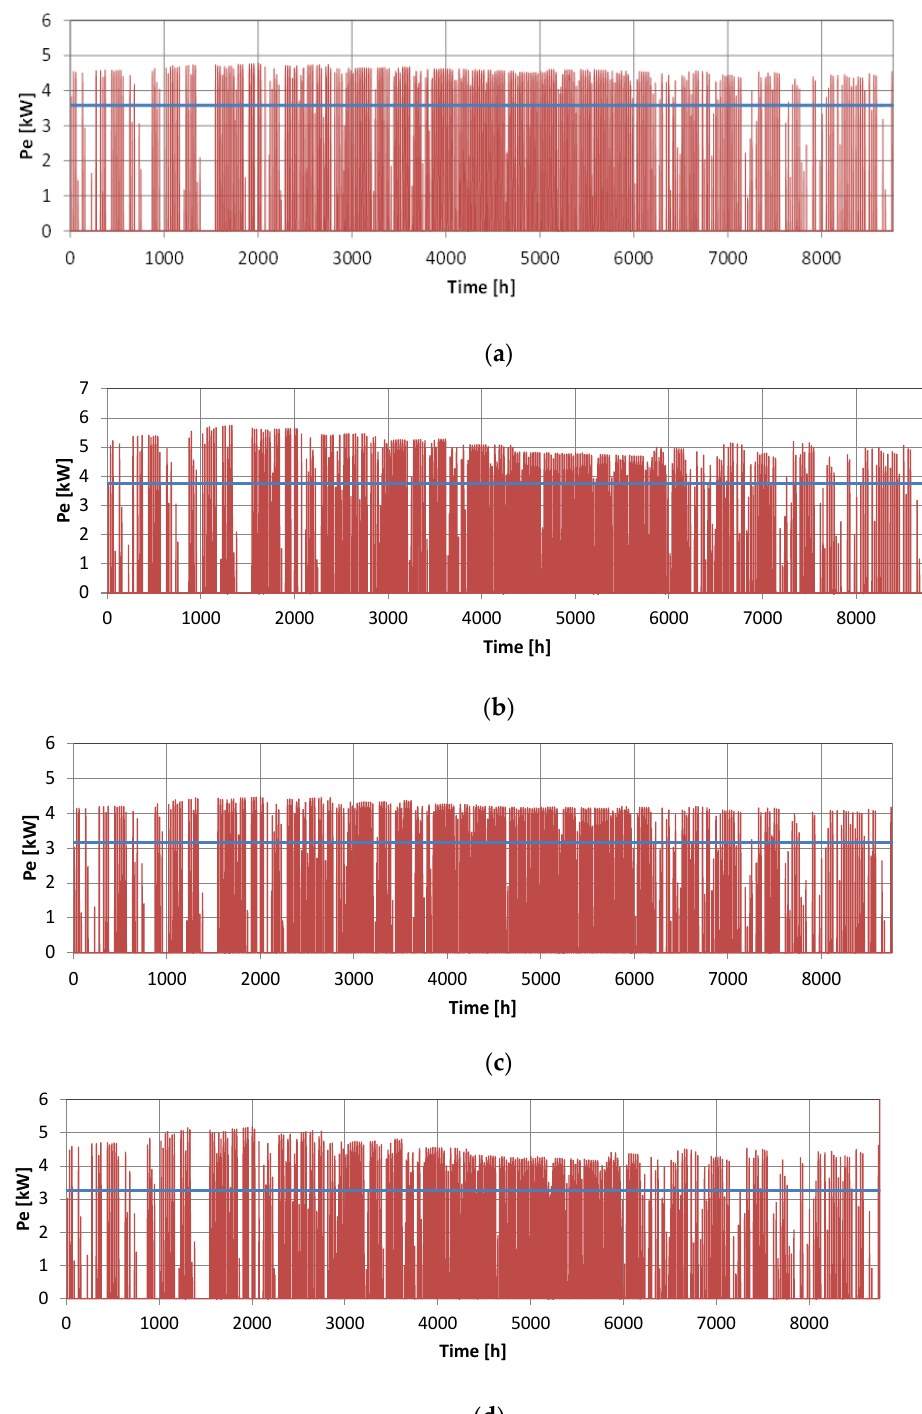
Figure 17. Annual DNI time-series measured at ENEA Casaccia site.